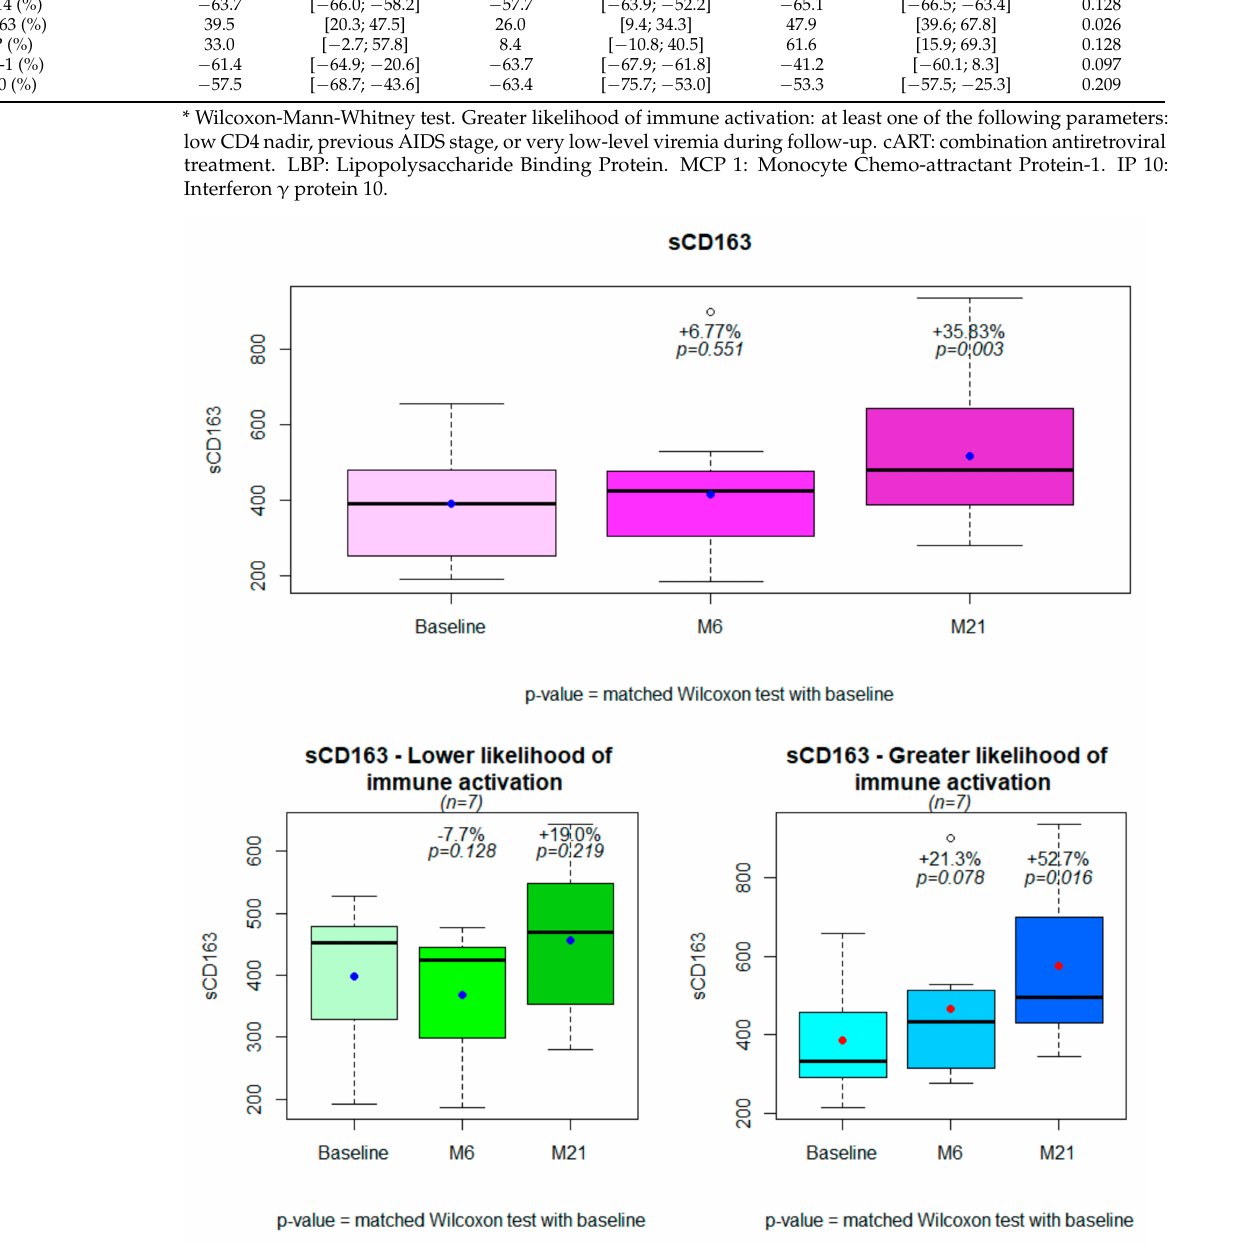
Figure 1. Changes in sCD163 from baseline to 6 months and 21 months after treatment simplification for the entire population ( n = 14) and in subjects with lower ( n = 7) or greater ( n = 7) likelihood of immune